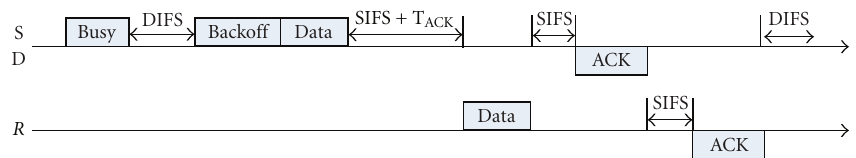
Figure 2: C-ARQ (cooperative retransmission scheme).